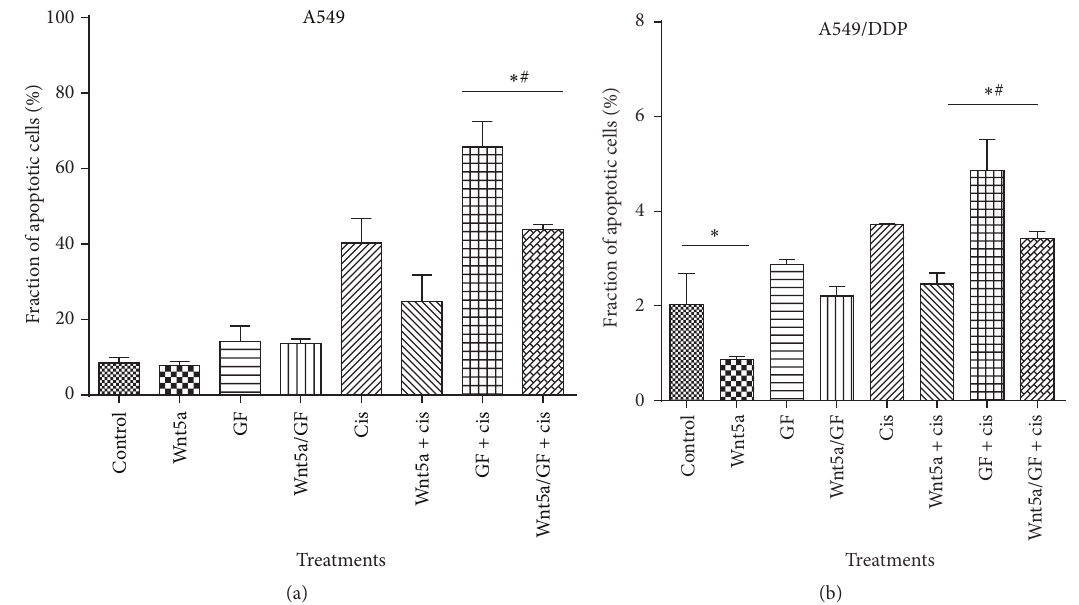
Figure 7: An inhibition of Wnt/calcium/PKC signaling induced apoptosis in lung cancer cells. A549 and A549/DDP cells were cultured in medium containing Wnt5a, PKC inhibitor GF109203X, and/or cisplatin. Cell apoptosis analyzed by a cytometric assay using an Annexin V-FITC/propidium iodide (PI) apoptosis detection kit. (a) Fractions of apoptotic cells in A549 cells treated with indicated conditions. (b) FractionsofapoptoticcellsinA549/DDPcellstreatedwithindicatedconditions.AnexposureofA549/DDPcellstoWnt5ashowedadecreased cell apoptosis, but an inhibition of Wnt/calcium/PKC signaling by GF109203 increased the apoptosis in both A549 and A549/DDP cells, regardless of the presence of Wnt5a or cisplatin. Compared to the Control-CM group, ∗ represents 𝑝 < 0.05 . Compared to the corresponding non-GF109203X-treated group, # represents 𝑝 < 0.05 . All data are represented as the mean ± SD of three independent triplicated experiments ( 𝑁 = 9 ). GF: